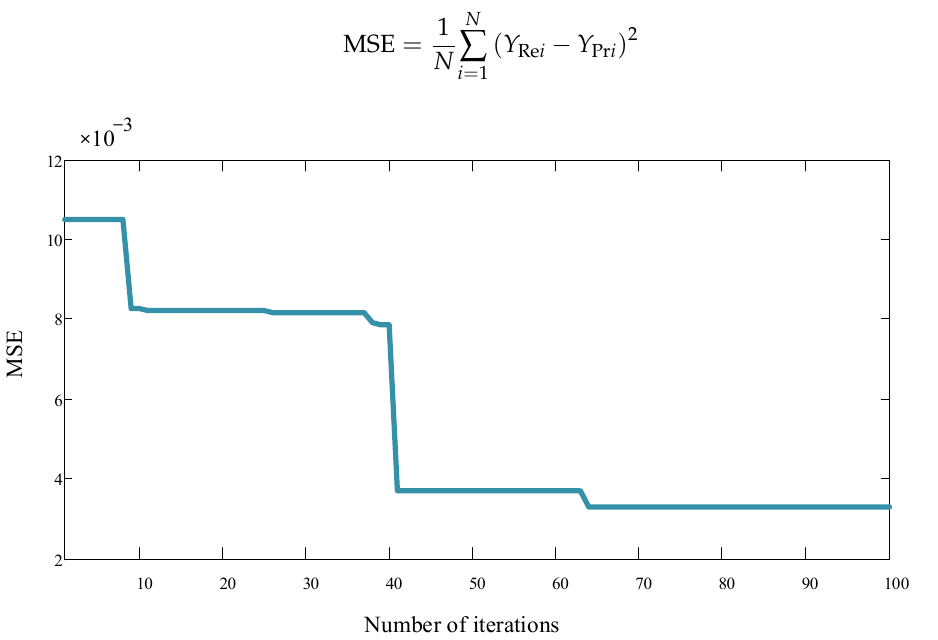
Figure 6. MSE of the initial proposed GA versus number of iterations.